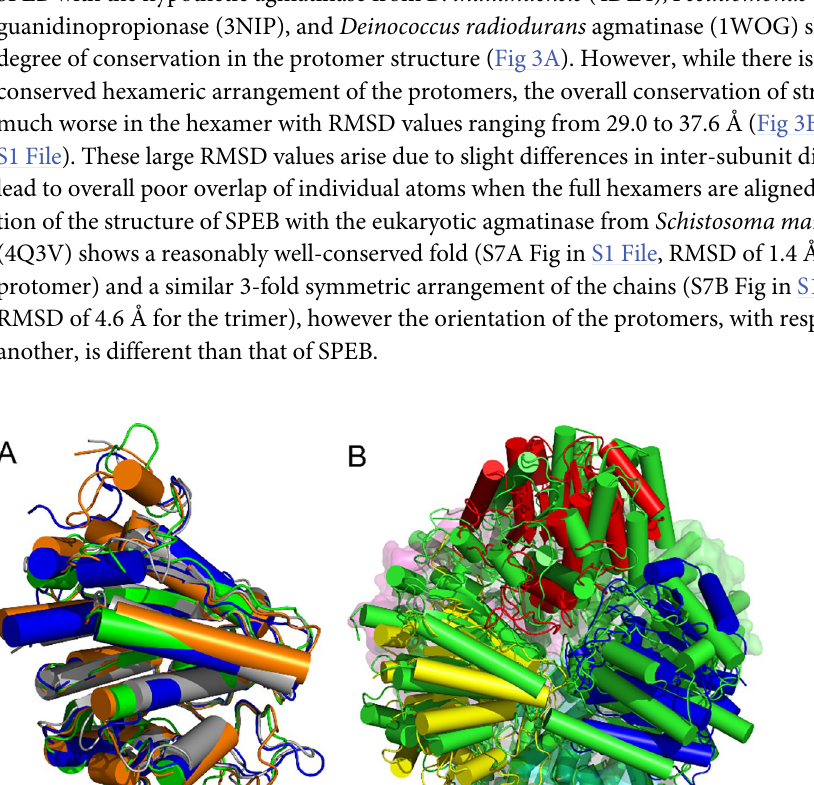
Fig 3. Comparison of SPEB to other arginase family proteins. The protomer of SPEB (A, green) superimposes well with the putative agmatinase from B . thailandensis (4DZ4, orange; RMSD 0.555 Å ), the guanidinopropionase from P . aeruginosa (3NIP, blue; RMSD 0.793 Å ), and the agmatinase from D . radiodurans (1WOG, gray; RMSD 1.13 Å ). While the overall orientation of the protomers in the hexamer is similar, the structural similarity is much lower for the hexamers with an RMSD of 37.7 Å between SPEB and 4DZ4 (B, SPEB in yellow, red and blue helices for top 3 chains, bottom 3 chains shown in cyan, green and purple surface representation; 4DZ4 in green helices, see S6 Fig in S1 File for superposition with 3NIP and